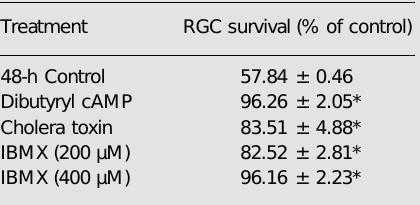
Table 2. cAMP and retinal ganglion cell survival.